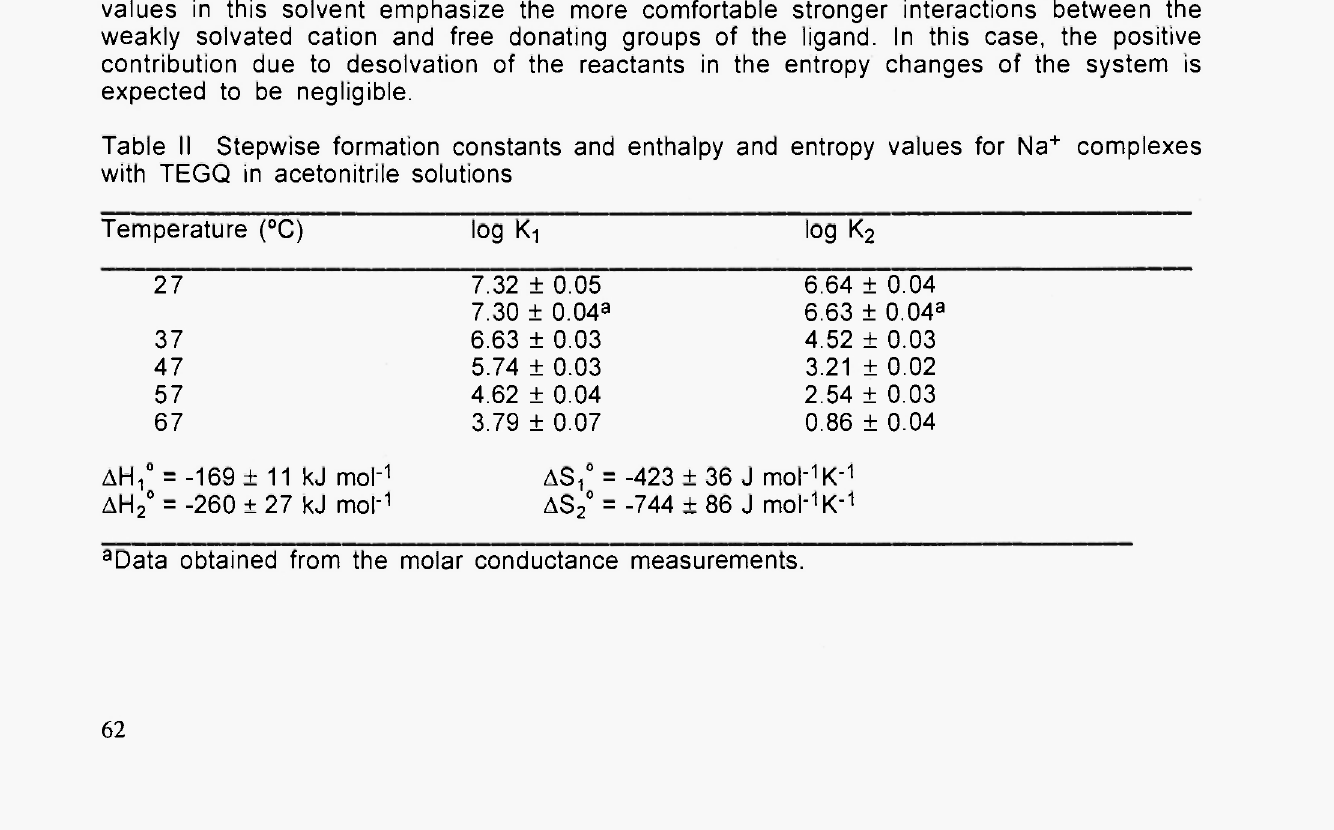
a Data obtained from the molar conductance